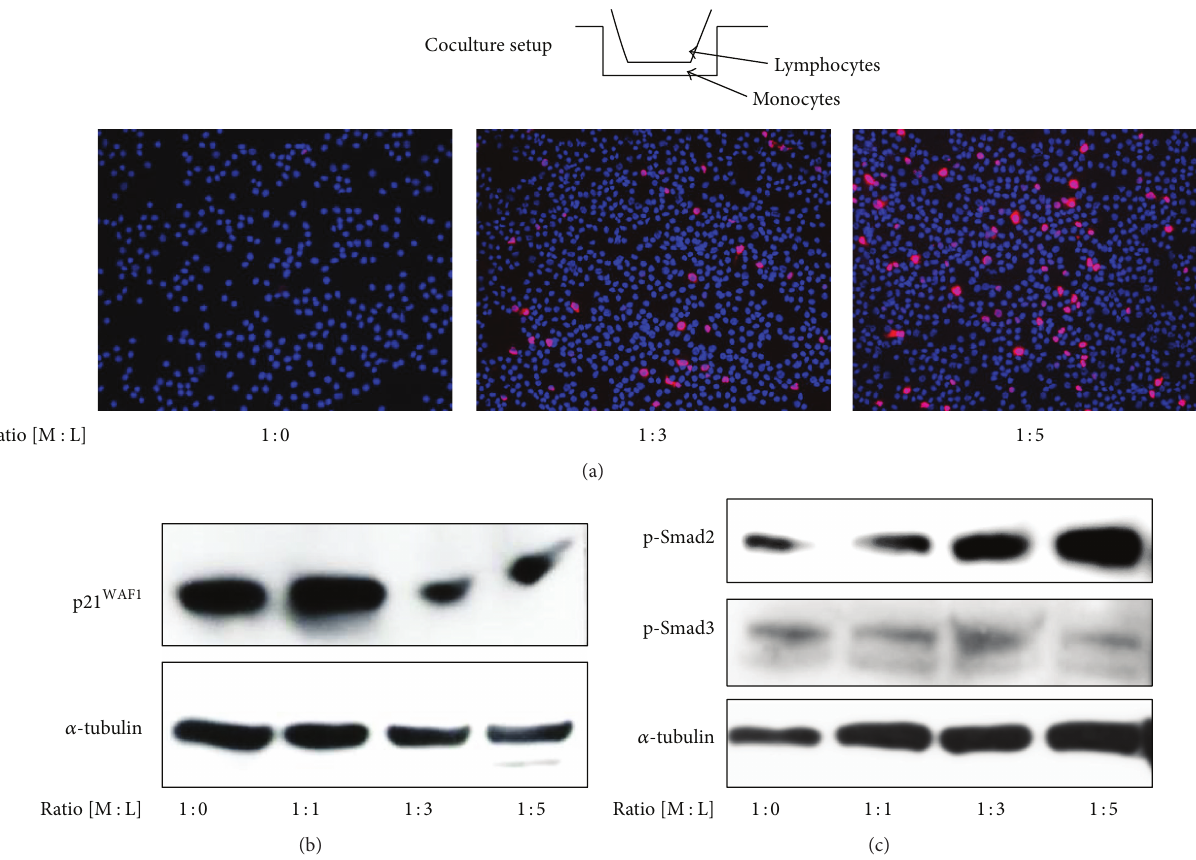
Figure 1: Coculture with lymphocytes increases the fraction of mitotically active PCMO. (a) Adherently growing peripheral blood monocytes isolated by elutriation were indirectly cocultured with increasing numbers of autologous lymphocytes in transwell inserts (top, pore size 0.4 𝜇 m). Ratios of monocytes (M):lymphocytes (L) are indicated below the images. After 4 days, cultured cells were fixed and double-stained with an antibody to Ki67 (magenta) and DAPI (blue) as control. The procedure of elutriation was described previously [25]. (b) Detection of p 21 WAF 1 expression in elutriated monocytes cocultured with lymphocytes at different ratios. After coculture, monocytes were lysed and analyzed for expression of p 21 WAF 1 by immunoblotting. The housekeeping protein 𝛼 -tubulin served as a loading control. (c) As in (b), except that the immunoblots were probed with antibodies to phospho-Smad2 (p-Smad2) and phospho-Smad3 (p-Smad3). Signal strengths of Smad3 and Smad2 should be assessed relative to those for 𝛼